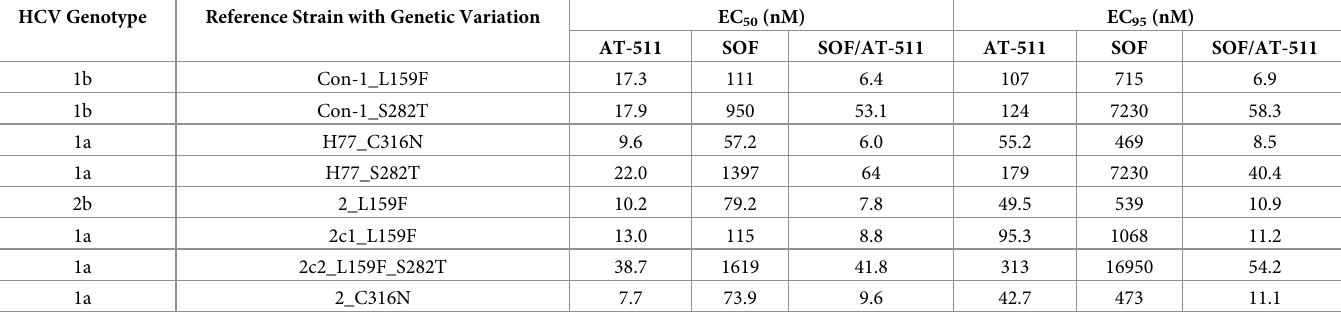
Table 3. Inhibition by AT-511 and SOF of HCV strains containing resistance-associated variants (RAVs). HCV Genotype Reference Strain with Genetic